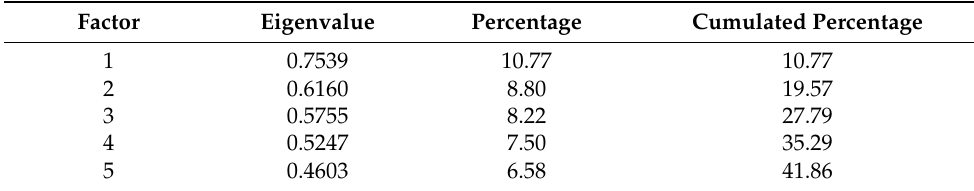
Table 3. MCA Parameters’ Values.